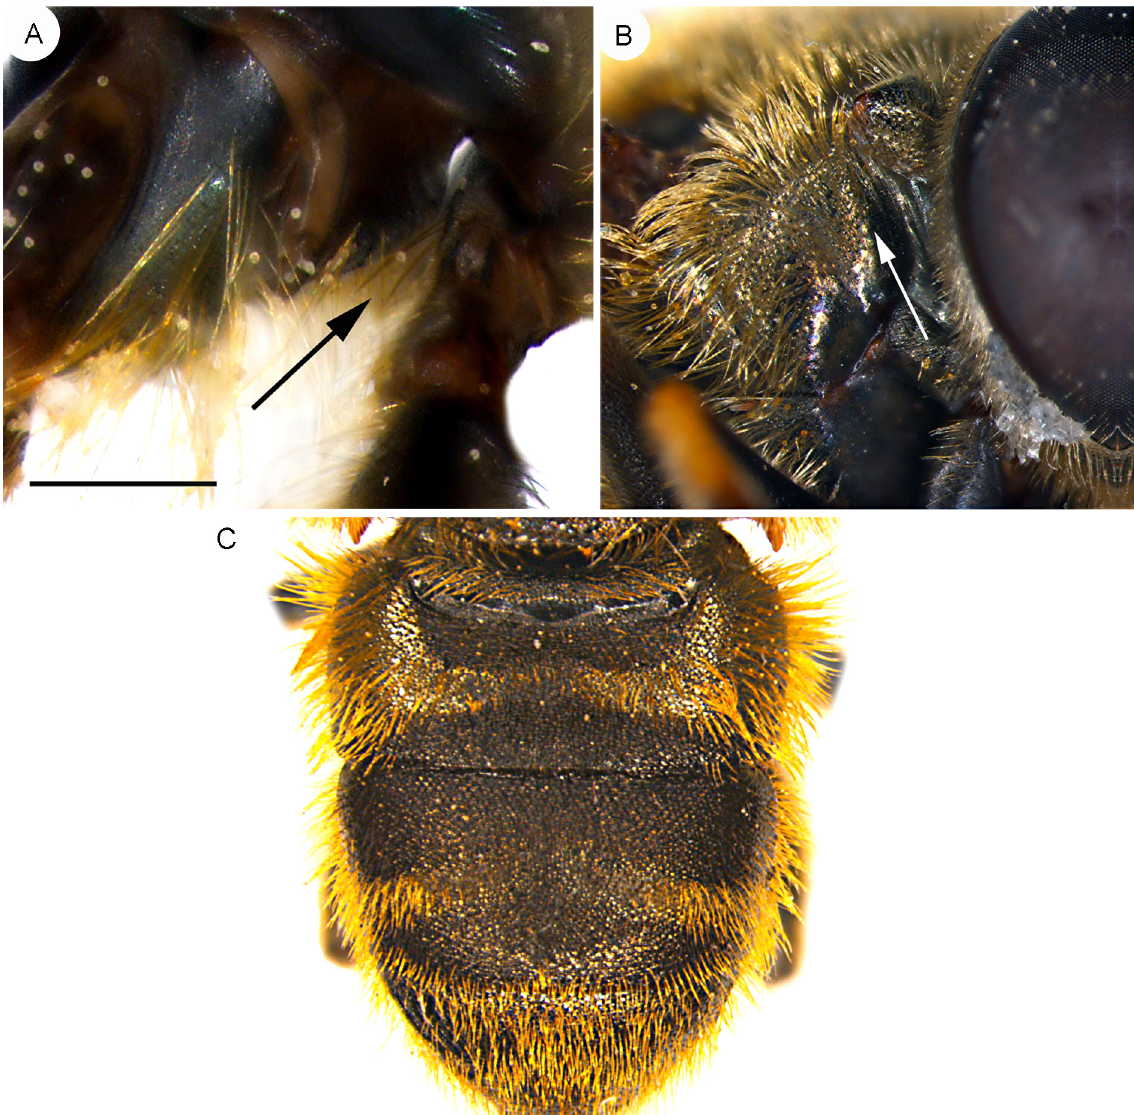
Fig. 2. A–C . Merodon funestus (Fabricius, 1794), ♂. A . Mid coxa (FSUNS; FSUNS ID F98), lateral view, posterior pile marked with arrow. B . Anterior anepisternum (CWM; FSUNS ID 10347), pile below postpronotum marked with arrow, anterolateral view. C . Abdomen, dorsal view (FSUNS; FSUNS ID F99). Scale bar = 2